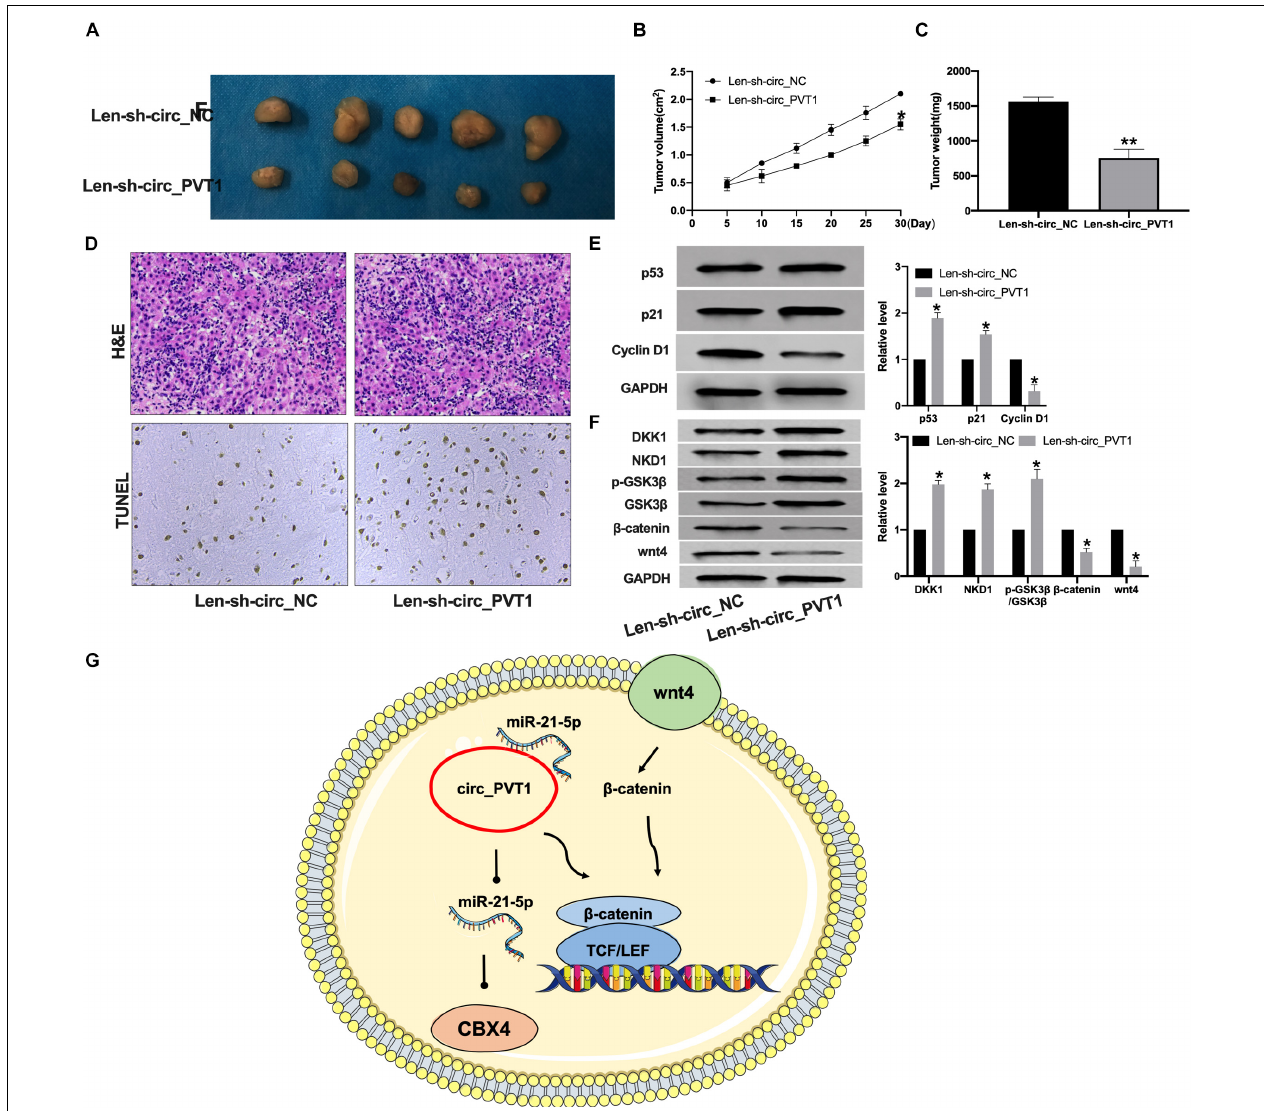
FIGURE 7 | Silencing of circ_PVT1 inhibits tumor growth in vivo . (A) The tumor image in Len-sh-circ_NC and Len-sh-circ_circ_PVT1. n = 5. (B,C) The tumor volume and weight were measured in Len-sh-circ_NC and Len-sh-circ_circ_PVT1 group. * P < 0.05. n = 5. (D) H&E staining in tumor tissues. (E) The protein level of p53, p21, and Cyclin D1 was detected in tumor tissues. * P < 0.05, ∗∗ P < 0 . 01. n = 5. (F) The protein level of DKK1, NKD1, phosphorylation-GSK3 β (p-GSK3 β ), GSK3 β , β -catenin, and wnt4 in tumor tissues. * P < 0.05, n = 4. (G) Model patterns of circ_PVT1/miR-21-5p/CBX4